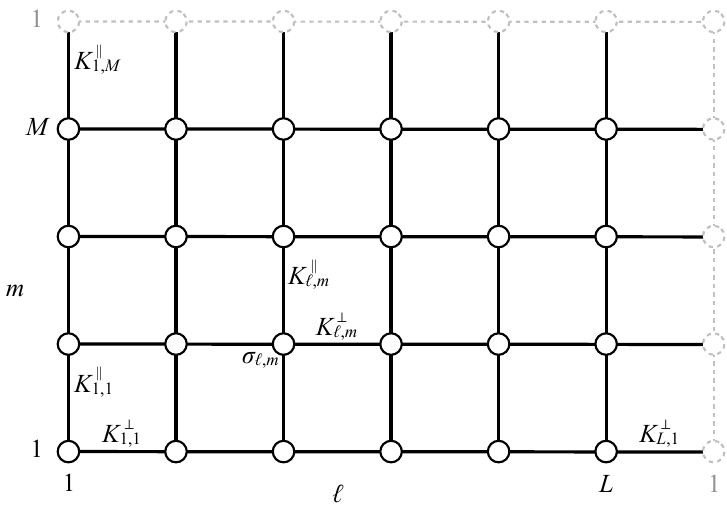
Figure 1: The square lattice with toroidal geometry for M = 4 and L =